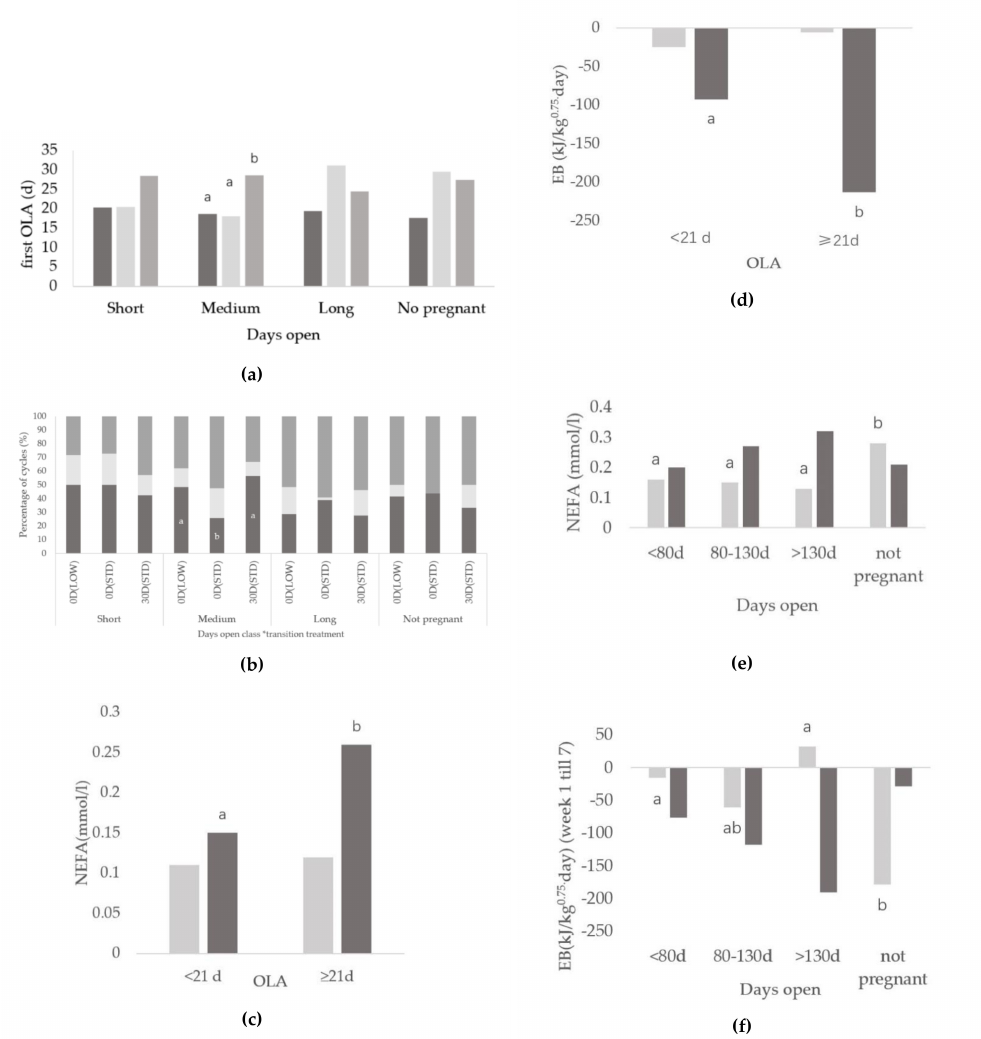
Figure A1. ( a ) interactions of di ff erent days open (short: < 80 d, medium:80–130 d, long: > 130 d and not pregnant) with di ff erent transition treatment (0-d DP (LOW) in dark grey, 0-d (STD) in light grey, 30-d DP (STD) in grey) for days to first OLA; ( b ) interactions of di ff erent days open (short: < 80 d, medium:80–130 d, long: > 130 d and not pregnant) with di ff erent transition treatment (0-d DP (LOW), 0-d (STD), 30-d DP (STD)) for di ff erent ovarian cycles (normal cycles (in dark grey), short cycles (in light grey) and prolonged cycles (in grey)); ( c ) interactions of di ff erent OLA ( < 21 d, ≥ 21 d) with di ff erent parity class (parity = 2 in light grey, parity ≥ 3 in dark grey) for plasma non-esterified fatty acid (NEFA) concentration; ( d ) interactions of di ff erent OLA ( < 21 d, ≥ 21 d) with di ff erent parity class (parity = 2 in light grey, parity ≥ 3 in dark grey) for energy balance (EB); ( e ) interactions of di ff erent days open (short: < 80 d, medium:80–130 d, long: > 130 d and not pregnant) with di ff erent parity class (parity = 2 in light grey, parity ≥ 3 in dark grey) for plasma non-esterified fatty acid (NEFA) concentration; ( f ) interactions of di ff erent days open (short: < 80 d, medium:80–130 d, long: > 130 d and not pregnant) with di ff erent parity class (parity = 2 in light grey, parity ≥ 3 in dark grey) for energy balance